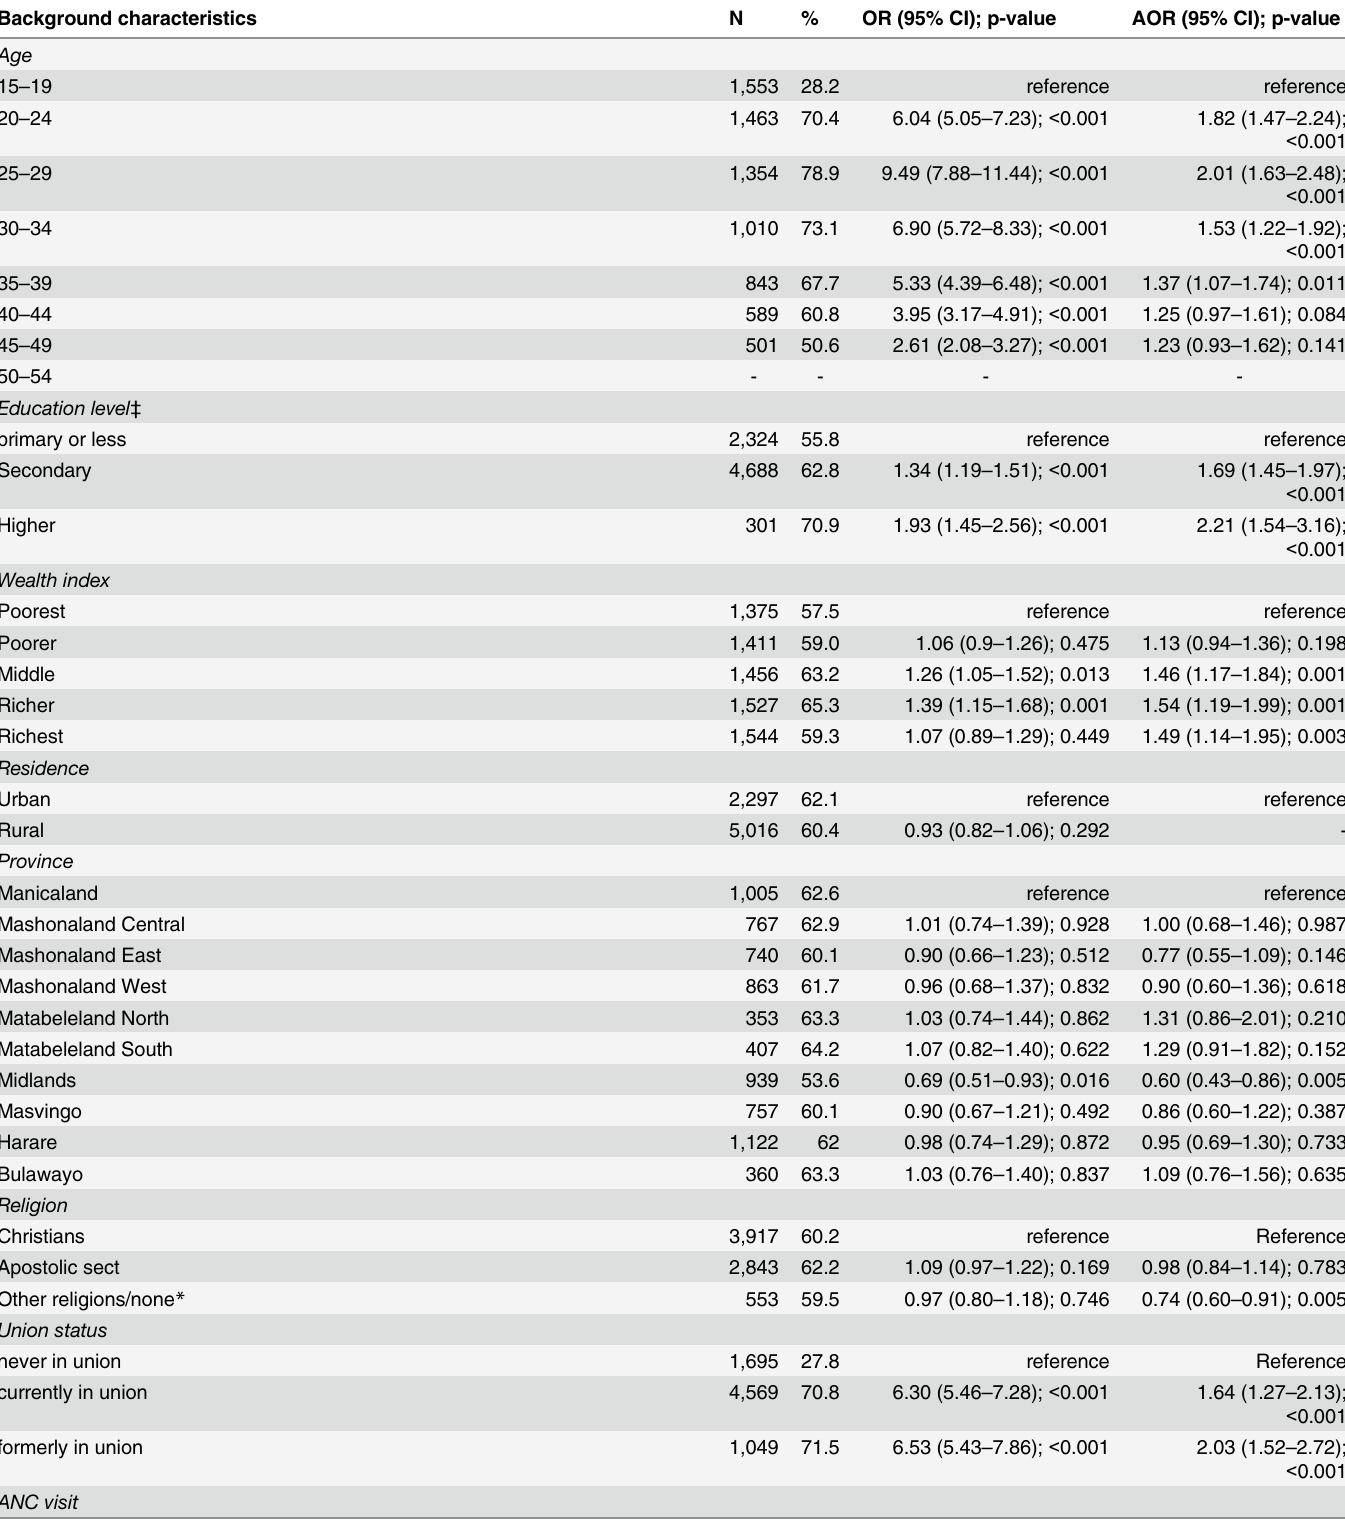
Table 2. Sociodemographic and sexual risk factors associated with ever being HIV-tested among female respondents, ZDHS 2010 – 11. Background